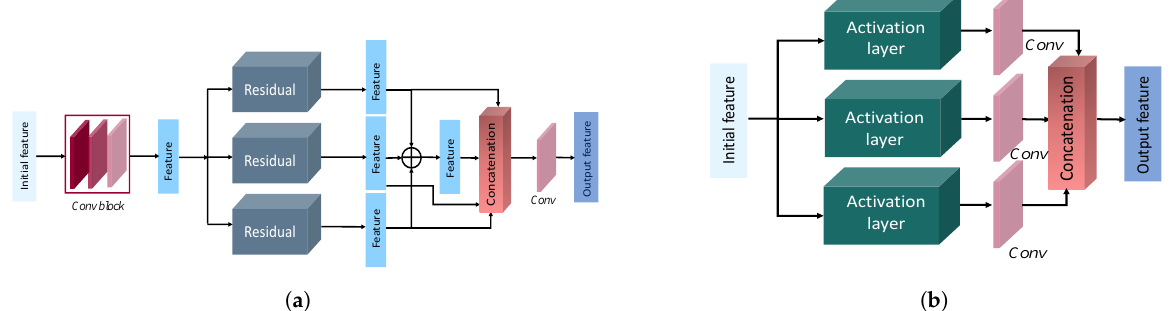
Figure 4. The first two modules in our proposed architecture. The first one is the residual feature aggregation module, and the second one is the multiactivation feature ensemble module. ( a ) Residual feature aggregation module. ( b ) Multiactivation feature ensemble